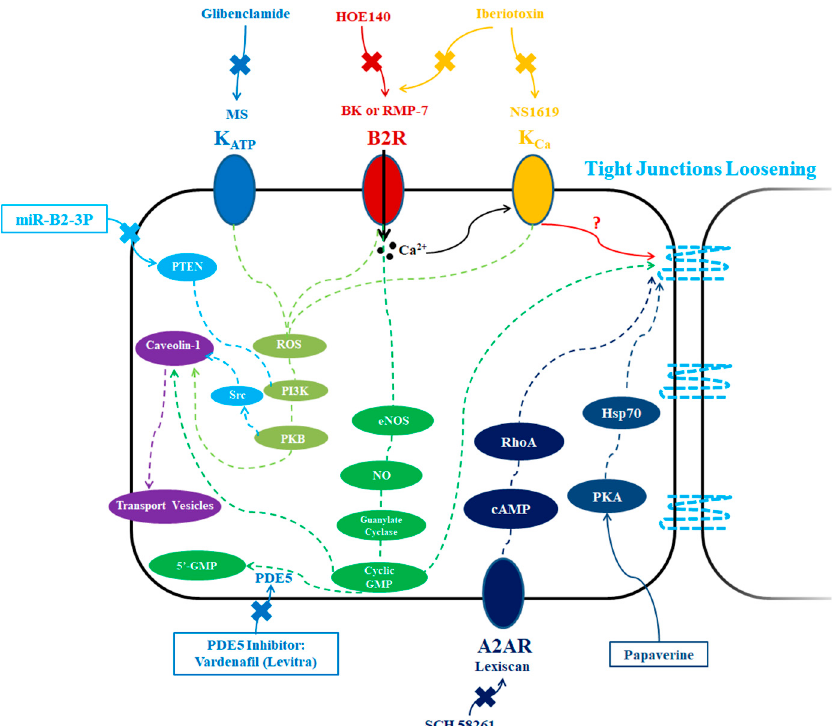
Figure 2. Biochemical modulators of tumor BBB permeability. To selectively open the BBB in